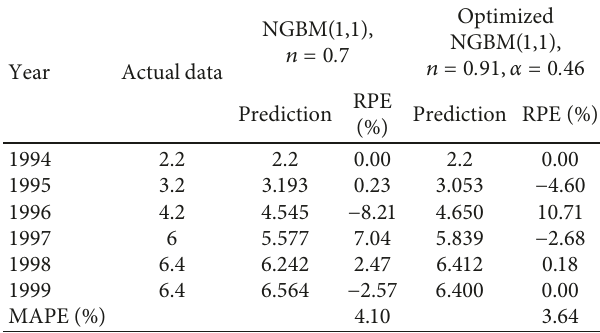
Table 3: Results of optoelectronic application from the two models.